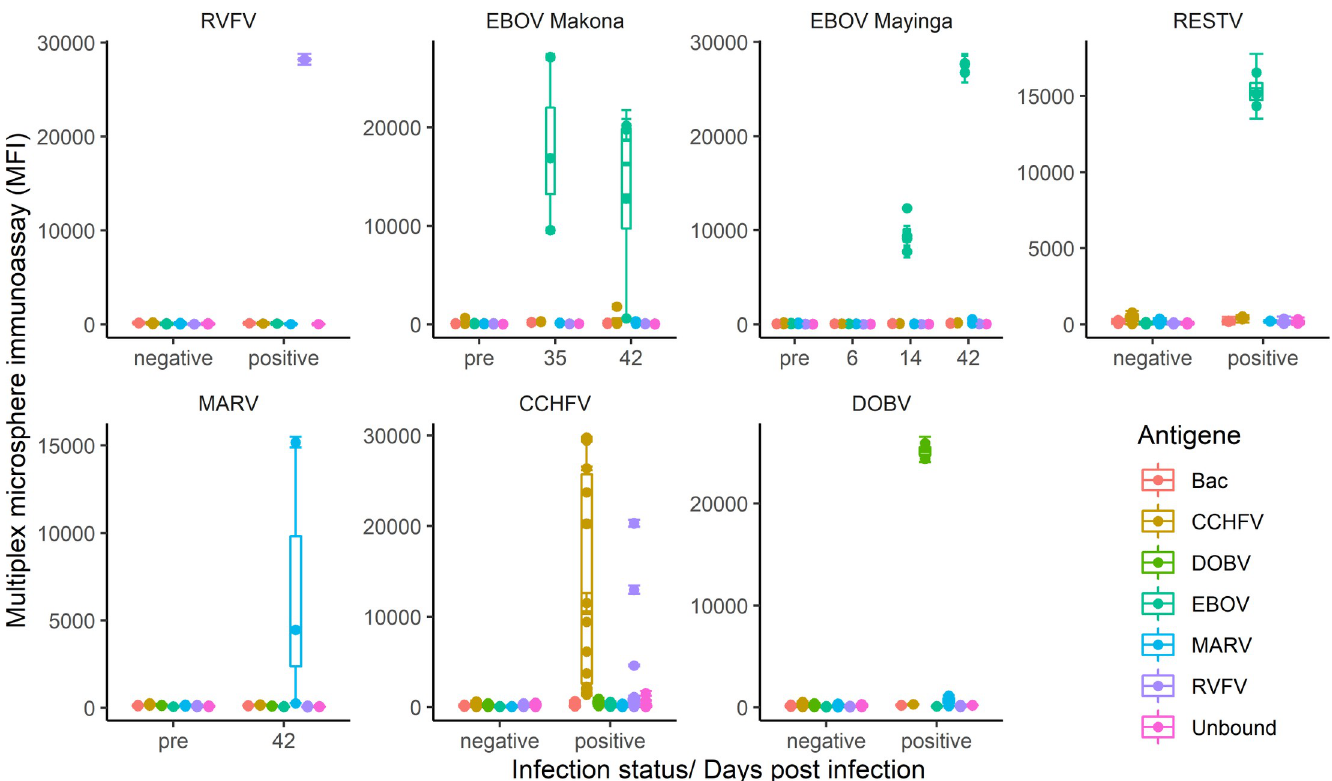
Fig 1. Validation of the MMIA using serum samples from humans or NHPs known to be infected with RVFV (1 NHP), EBOV (14 NHPs), MARV (3 NHPs), CCHFV (10 humans from Tajikistan or Nigeria), or DOBV (2 humans from Europe). Previously characterised serum samples were used as a validation panel to confirm the ability of the MMIA to detect anti-NP antibodies generated in response to infection with these viruses. These serum samples were assayed by MMIA under the same conditions that were used to assay the serum panels from the German blood bank and Guinea, thus providing a range of MFI values for each viral NP coupled microsphere region for known positive serum samples. For EBOV and MARV validation, serum taken from each NHP prior to experimental infection (pre) is compared to serum taken at various time points post-infection. For the RVFV NHP serum and for CCHFV and DOBV human serum, samples taken at a single time point after infection are compared to presumed negative human serum samples.